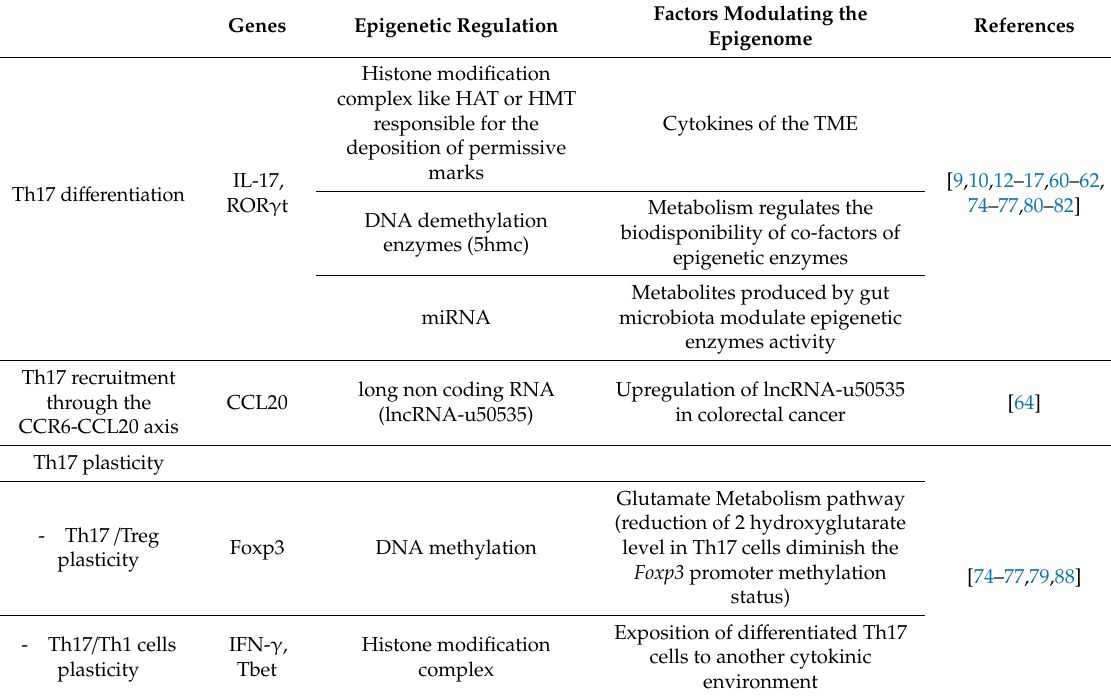
Table 1. Factors modulating the epigenetic regulation of genes involved in Th17 di ff erentiation, recruitment or plasticity in the context of